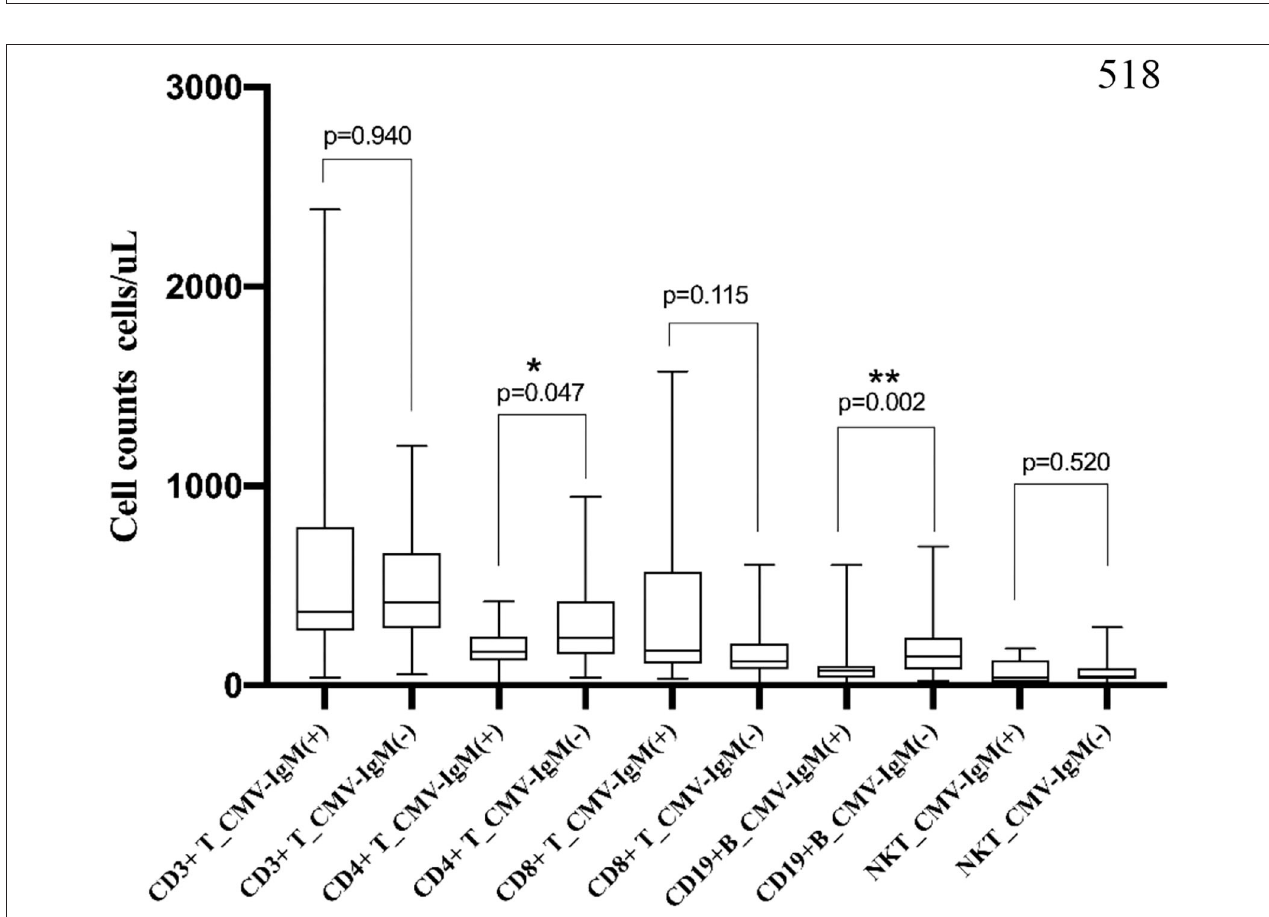
FIGURE 4 | Association of lymphocyte subset and CMV-IgM in MDA5 + DM. CD4 + T cell counts were significantly decreased in CMV-IgM + group compared with CMV-IgM − group (245.7 cells/ µ L, IQR 167.1–374.1 cells/ µ L vs. 420.6 cells/ µ L, IQR 238.1–603.4 cells/ µ L, p = 0.047). CD 19 + B cell counts was also much lower in CMV-IgM + group than CMV-IgM − group (420.6 cells/ µ L, IQR 238.1–603.4 cells/ µ L vs. 240.6 cells/ µ L, IQR 146.4–372.2 cells/ µ L, p = 0.006) cells/ul, p = 0.006). * P < 0.05, ** P < 0.01.